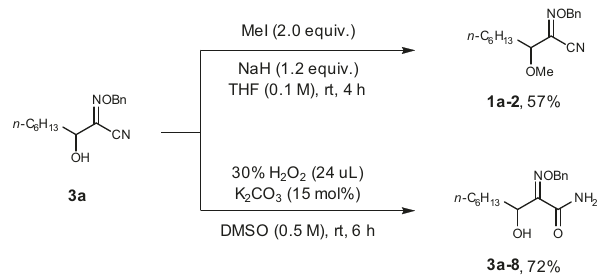
Fig. 8 The chemo-selective transformation of 3a. The oxime ether product 3a could be easily converted to methylated product 1a-2 and amide 3a-8 . NATURE COMMUNICATIONS| (2021) 12:2131